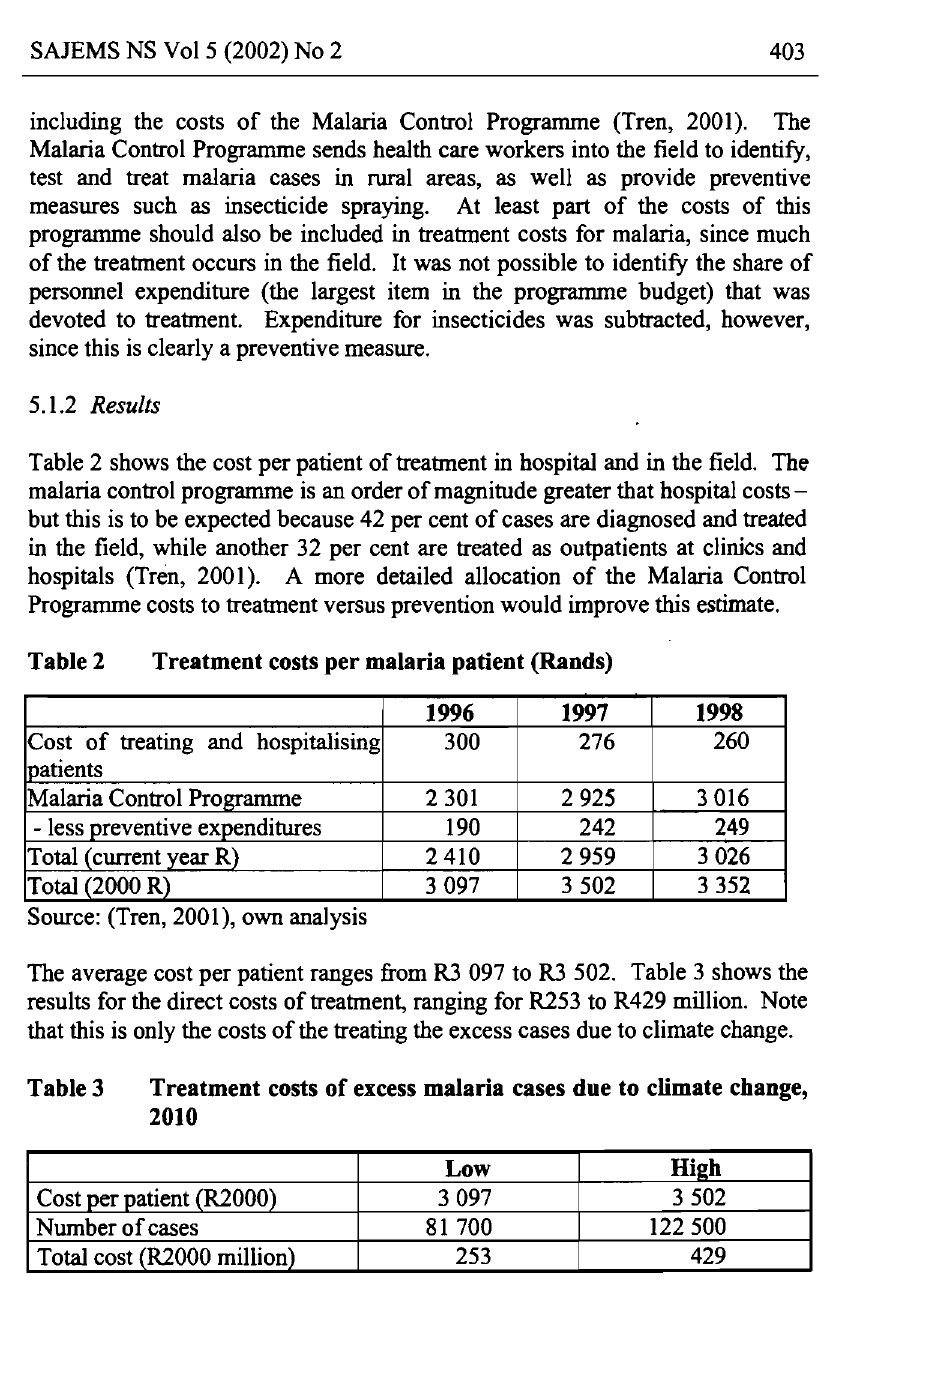
Treatment costs of excess malaria cases due to climate change,